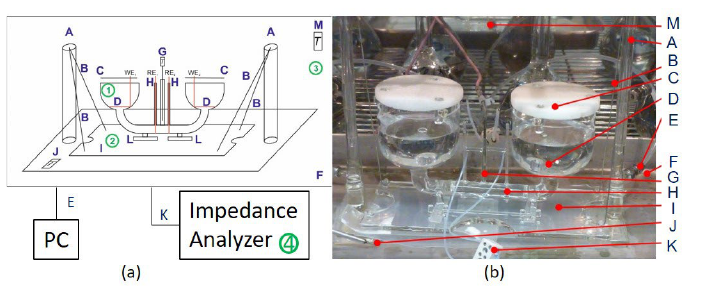
Fig. 1. In-house developed conductivity measurement setup: (a) scheme with four main parts: (1) electrochemical cell, (2) pneumatic seesaw, (3) climate chamber, (4) impedance analyser and computer controller; (b) photo of the setup showing the quartz electrochemical cell positioned on the quartz pneumatic seesaw and located inside the climate